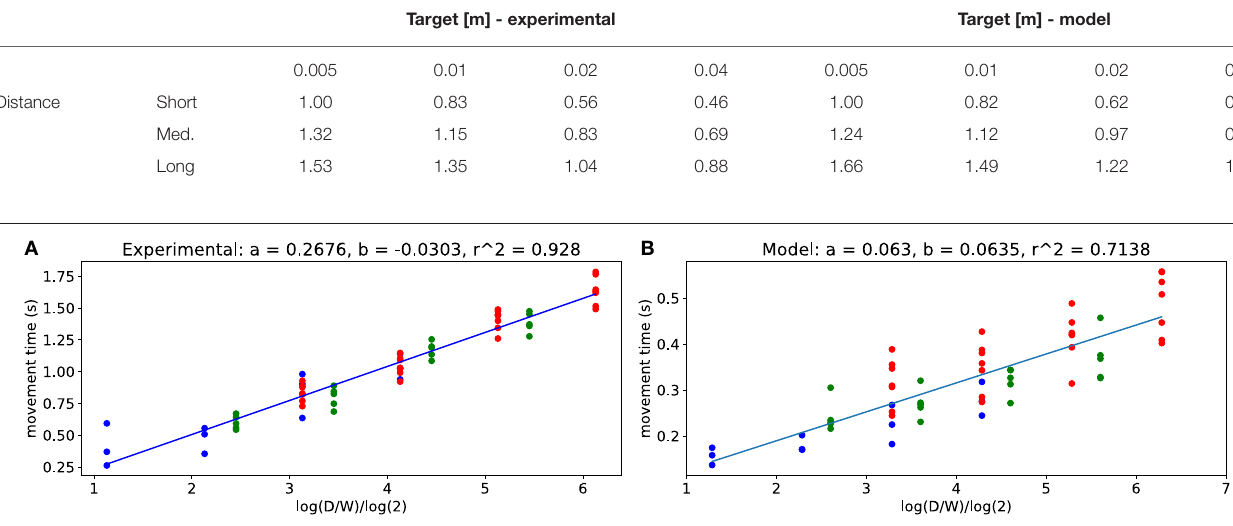
TABLE 2 | Movement time relationship to target size and distance (normalized to the first value).